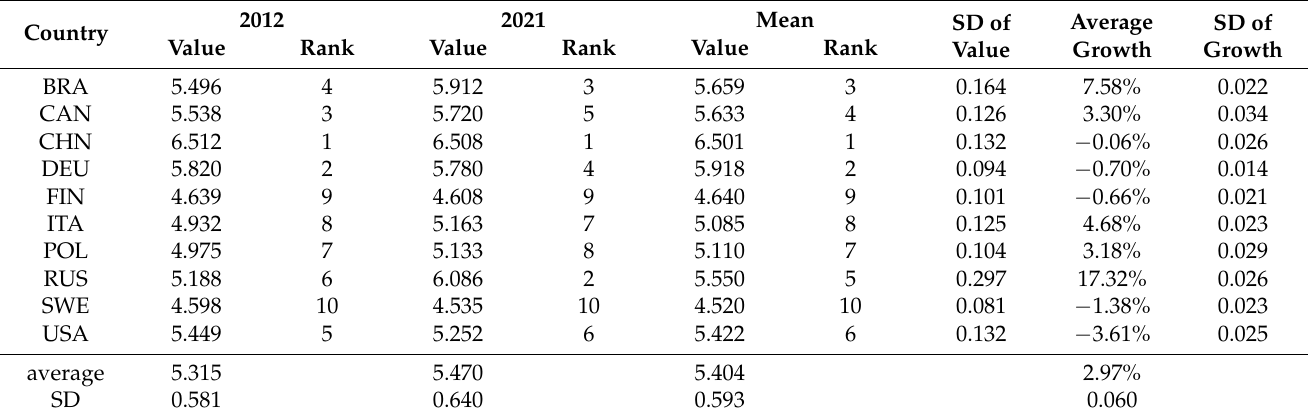
Table 6. The results of international competitiveness of wood-based